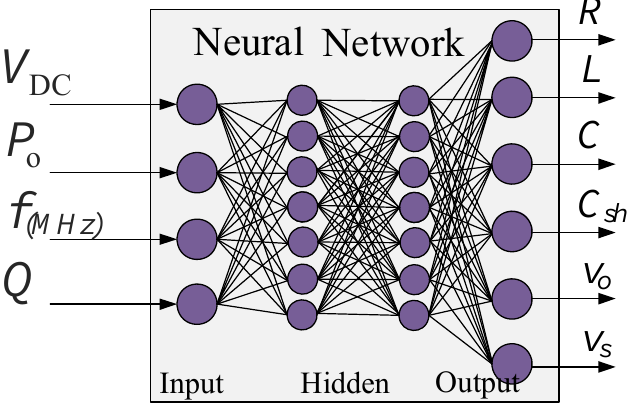
Figure 4. Proposed MLP architecture.